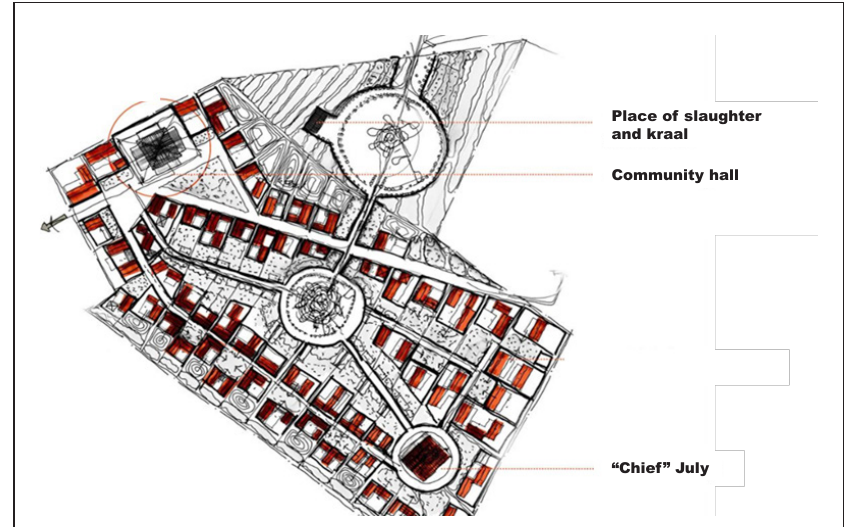
Figure 10: Umgidi Cultural Village